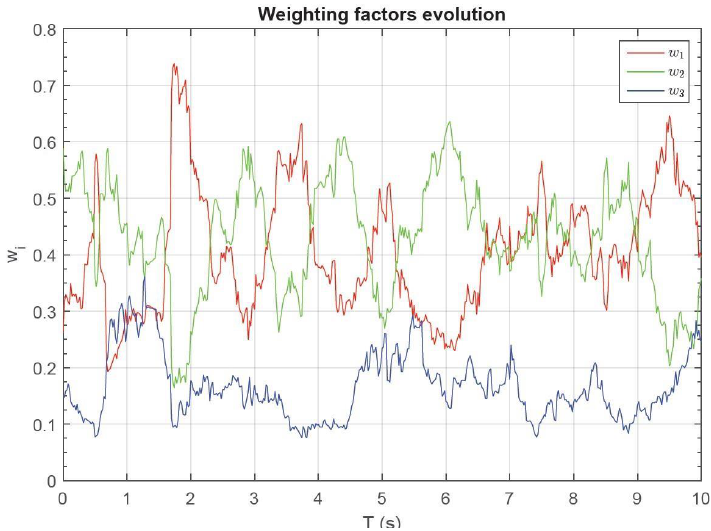
Figure 14. Evolution of the adaptive weighting